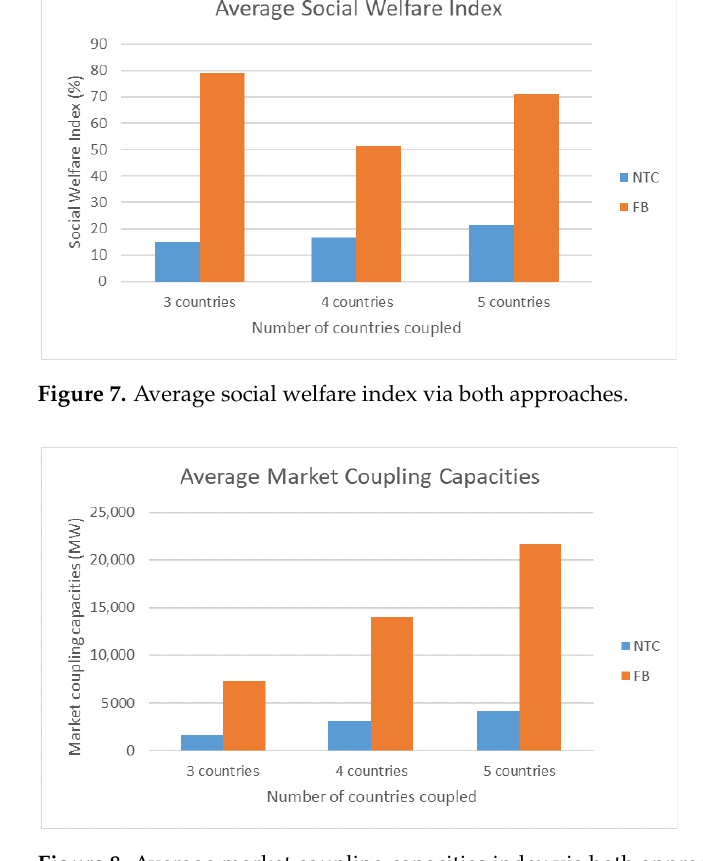
Figure 10. Total social welfare in euro via both approaches. Finally, to give an overall view of the coordinated capacity calculation on cross-bor- ders via market coupling procedure in the SEE region, a total performance index is intro- duced. The total performance index is defined in Equations (4) and (5) and gives a quick assessment of the effectiveness and performance of the NTC and FB approach, as these functionalities are tested in the frame of CROSSBOW ROC. This index is given in percent- age (%) and is obtained by combining the two basic indexes of SW (%) and PC (%). The concept for TP (%) is a simple and prompt total evaluation of the NTC or FB method in every test case scenario. Thus, as the SW index increases and the PC index decreases, the TP index has a significant increase and the method examined is presented to be more ef- fective in general terms. In Figures 11 and 12, the TP index is depicted in a graphical way for both NTC and FB approach, respectively.